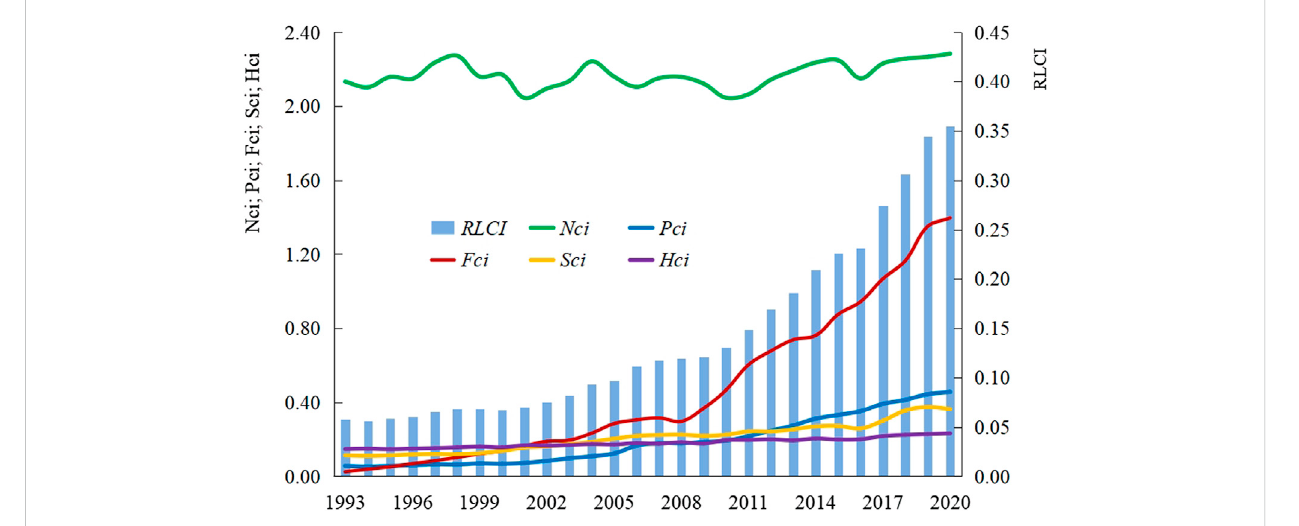
FIGURE 5 Development of regional livelihood capital in Diqing (1993 –